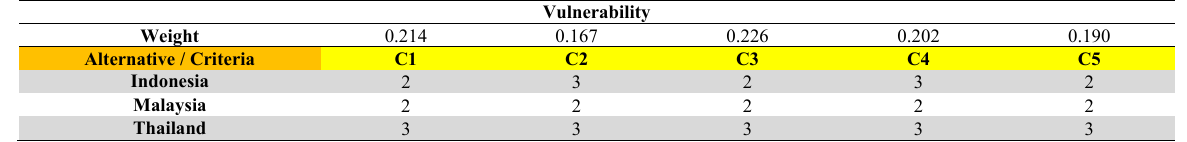
Calculation of the risk analysis matrix for the Vulnerability Aspects